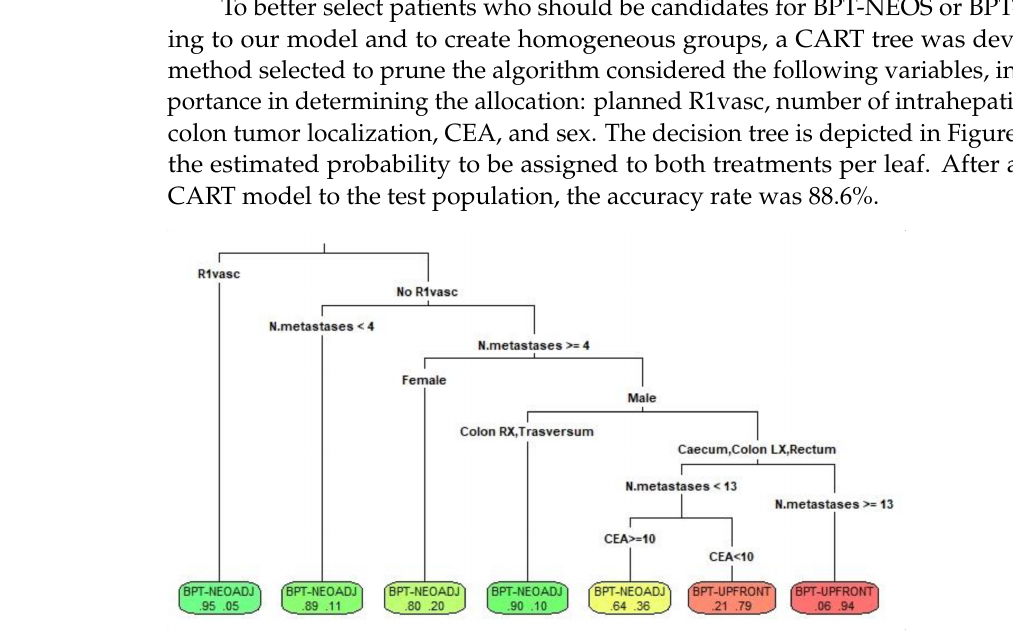
Figure 4. The decision tree obtained by CART is here depicted. The first number in the last leaf represents the probability to be submitted to a neoadjuvant regimen, while the second number is the probability to be assigned to upfront surgery. (Colon RX: right colon tumor, Colon LX: left colon